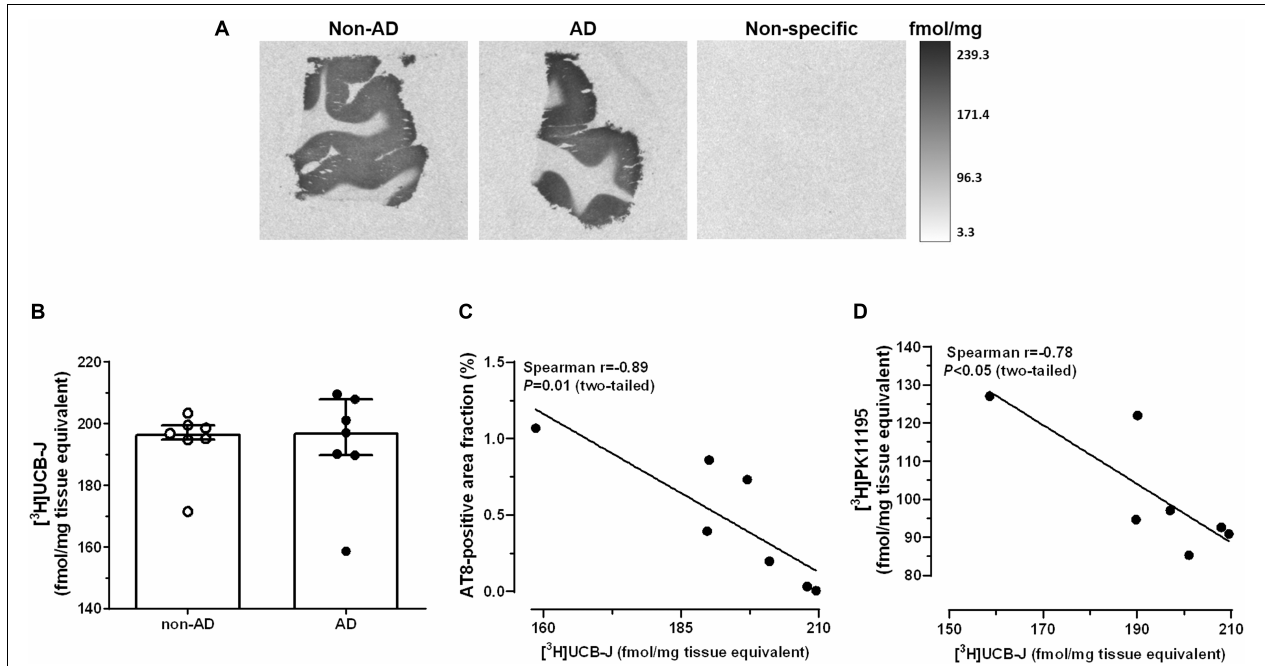
FIGURE 3 | Autoradiography of [ 3 H]UCB-J binding sites. (A) Representative autoradiograms of SV2A binding sites in the middle frontal gyrus of non-demented subjects and AD patients. (B) There were no differences in [ 3 H]UCB-J binding levels between AD and non-AD subjects ( P > 0.05, Mann-Whitney U tests, two-tailed). (C,D) In AD patients, [ 3 H]UCB-J binding density was negatively correlated with AT8 immunoreactivity (C) and [ 3 H]PK11195 binding levels (D) . Results are presented as the median and interquartile range of n = 7